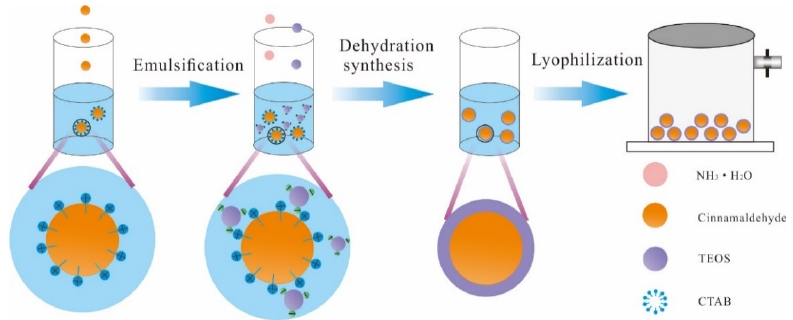
Figure 1. Schematic illustration for the synthesis of SiO 2 -CA microcapsules.